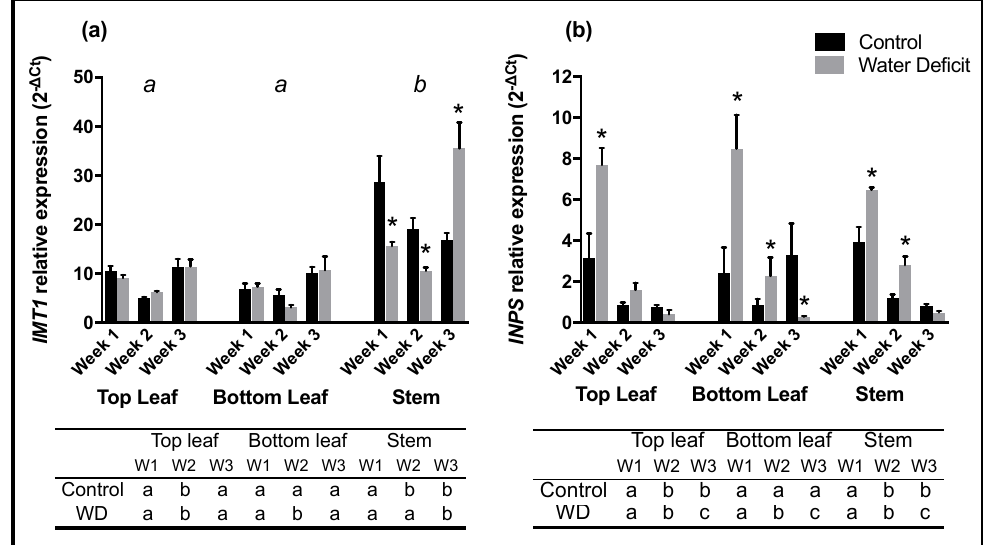
Figure 4. Relative expression profiles of IMT1 ( a ) and INPS ( b ) genes in soybean leaf and stem samples subjected to well-watered control (black columns) and drought stressed conditions (grey columns). Samples were collected at approximately 14:00 on the day gas exchange measurements there taken. Leaves located a node above (top leaf), a node below (bottom leaf) the gas exchange leaf and the stem portion in between were harvested for this analysis. Columns denote the average concentration obtained from 4 plants. Bars represent the standard error from the mean ( n = 4). Letters above figures denote significant ( p < 0.05) differences between plant organs sampled. Asterisk (*) indicates significant difference ( p < 0.05). Table below histogram denotes significant ( p < 0.05) differences between sampling week and treatment.